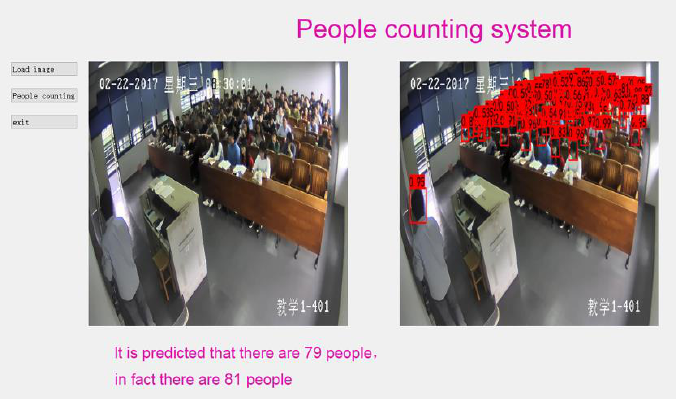
Figure 8. One example of people counting results. There are 79 people in the classroom, and it was predicted that there would be 81 people. The result is not completely correct.